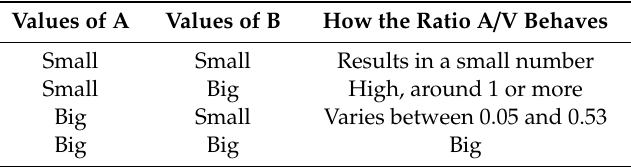
Table 3. Student considerations on the e ff ect of A and V values over A / V ratio. Values of